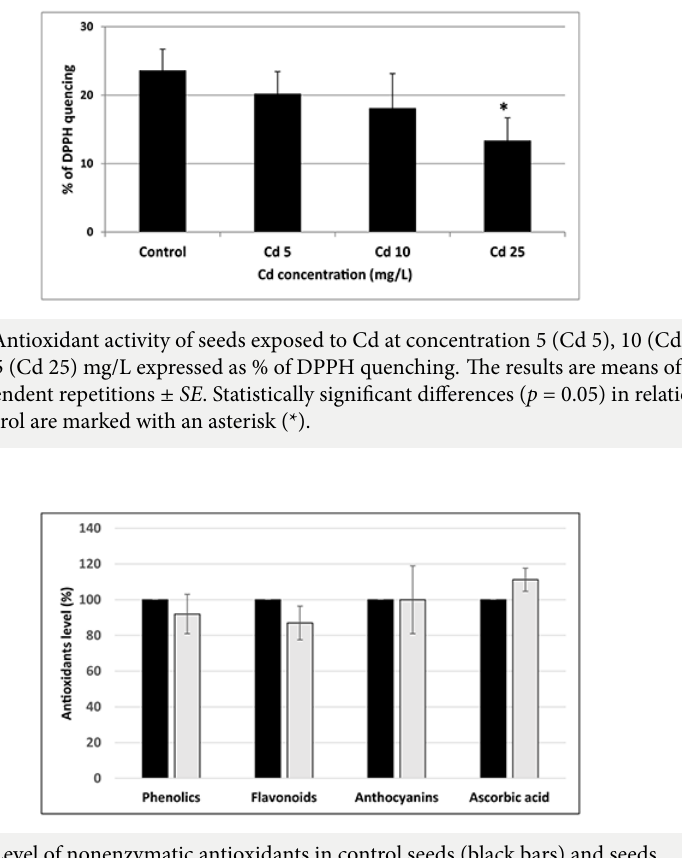
Figure 4 Level of nonenzymatic antioxidants in control seeds (black bars) and seeds treated with Cd at the concentration 25 mg/L (light greybars) expressed as % in relation to the control. The results are means of three–four independent repetitions ± SE . No significant differences were noted.